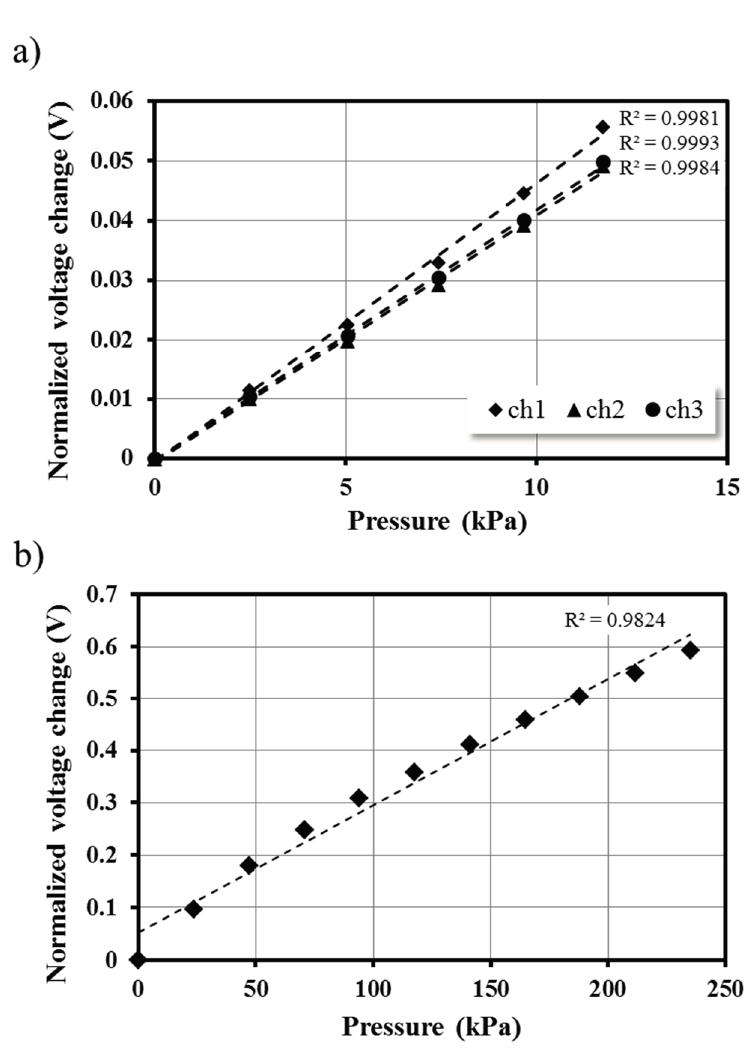
Figure 3. Calibration of the pressure sensors. Calibration results of each pressure sensor in the proposed device with pressure of ( a ) 12 kPa and ( b ) 230 kPa. From the linear regression analysis, the calibration results show large linearity ( R 2 > 0.999 for 12 kPa, and R 2 > 0.982 for 230